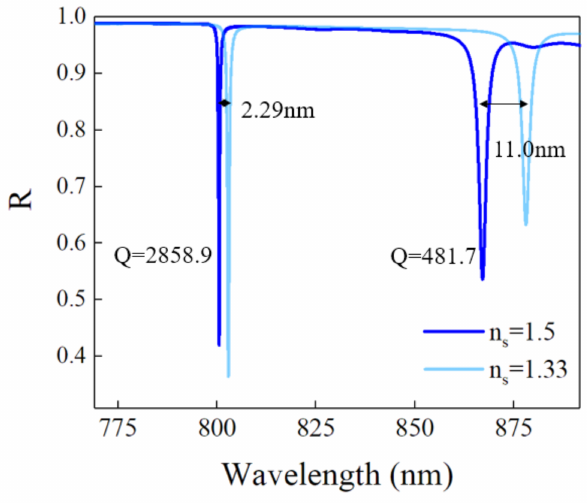
Figure 10. The shifts in the peak positions and the Q factor when both the waveguide and the grating layer are metal and the surface refractive index is changed from 1.33 to